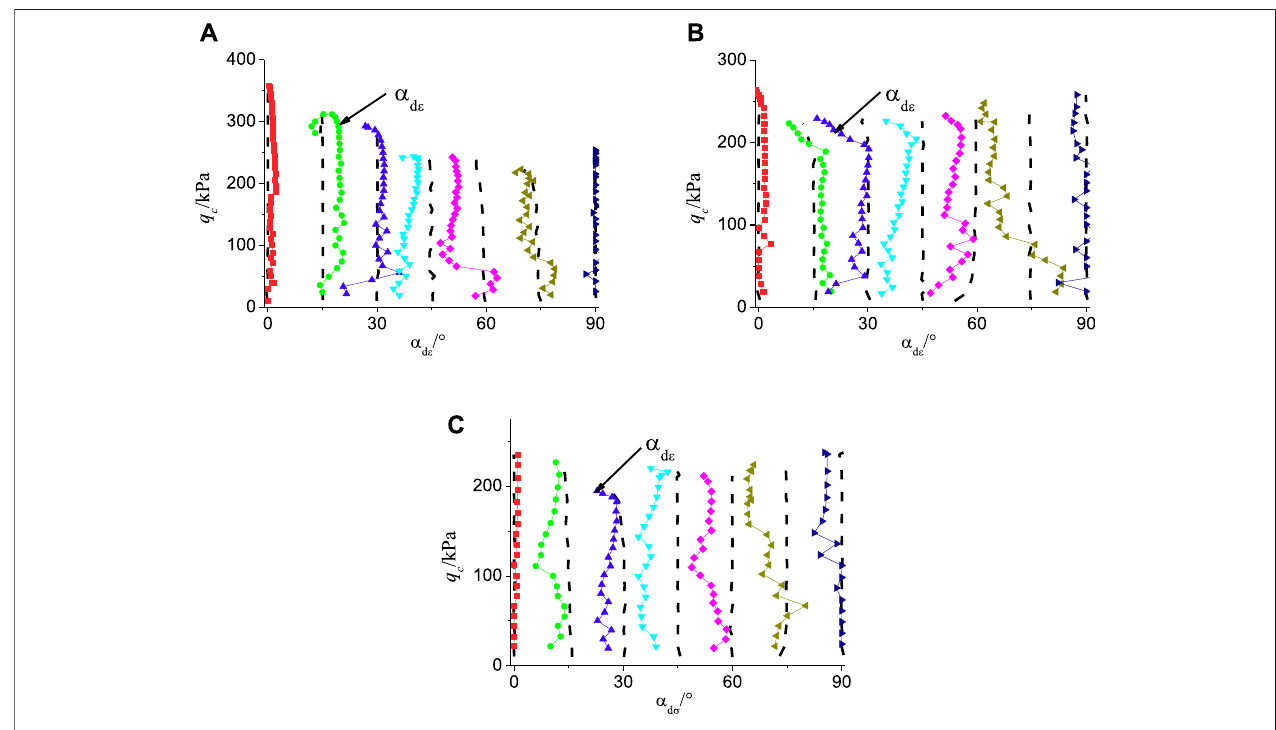
FIGURE 10 | Variation of strain increment angle of remolded loess at different medium principal stress ratios: (A) b = 0; (B) b = 0.5; (C) b = 1